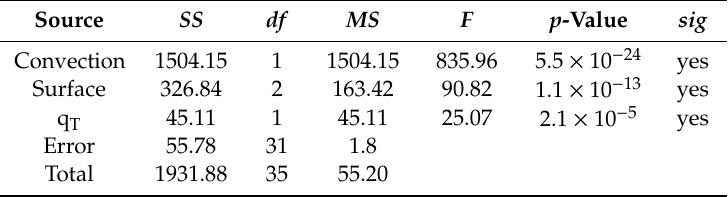
Table 10. Results of ANOVA for total heat transfer coe ffi cient.